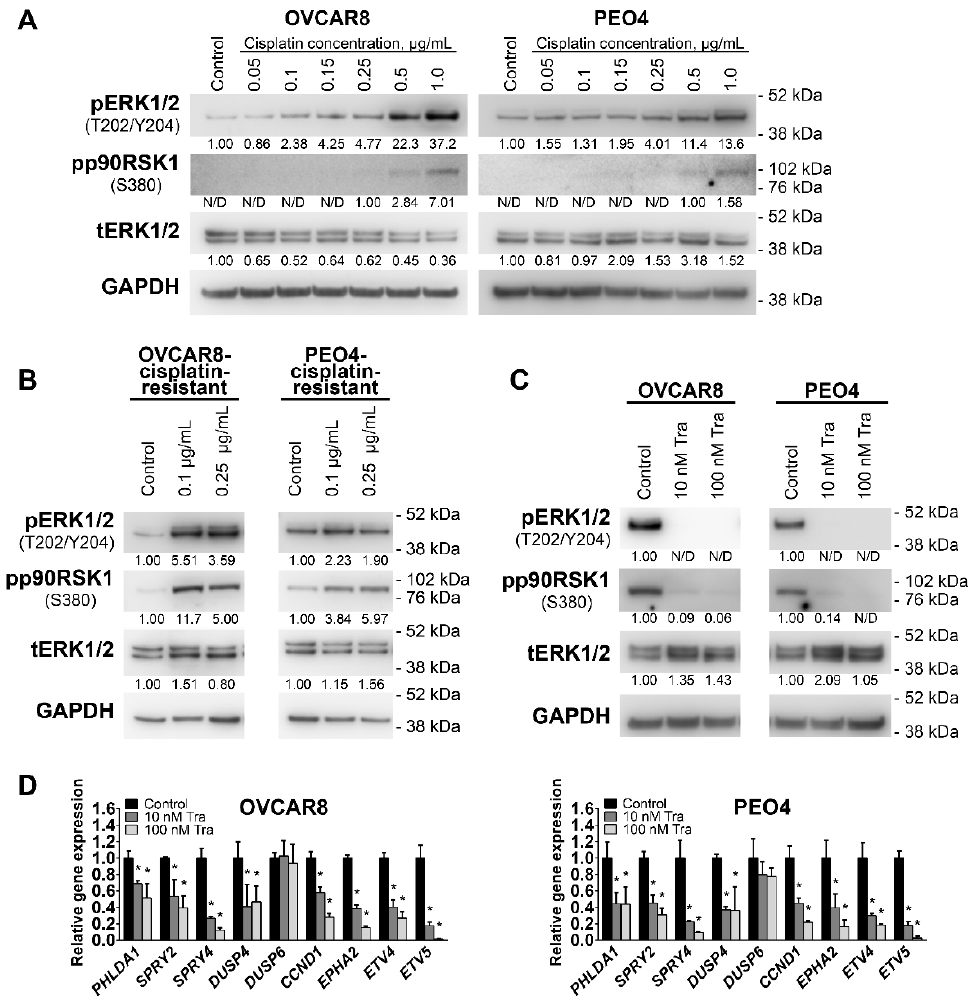
Figure 3. ( A ) Immunoblotting analysis of MEK1/2-ERK1/2 pathway component activities in cells treated with cisplatin for 24 h. Numbers under the bands represent relative intensity normalized to GAPDH levels and Control samples, except pp90RSK1 data that were normalized to samples showing the weakest detectable band intensity. ( B ) Immunoblotting analy- sis of MEK1/2-ERK1/2 pathway component activities in cells resistant to the indicated concentrations of cisplatin. Numbers under the bands represent relative intensity normalized to GAPDH levels and Control samples. ( C ) Immunoblotting analysis of MEK1/2-ERK1/2 pathway component activation in cells treated with trametinib for 24 h. Numbers under the bands repre- sent relative intensity normalized to GAPDH levels and Control samples. ( D ) Gene expression levels of MEK1/2-responsive genes in cells treated with trametinib for 10 h. Data are normalized to “Control” samples and presented as mean+S.D. ( n = 3, two-tailed Student’s T-test with Welch’s correction, * - p < 0.05). Tra—trametinib, pERK1/2—phosphorylated ERK1/2, tERK1/2—total ERK1/2, pp90RSK1—phosphorylated p90RSK1, N/D—non-detectable